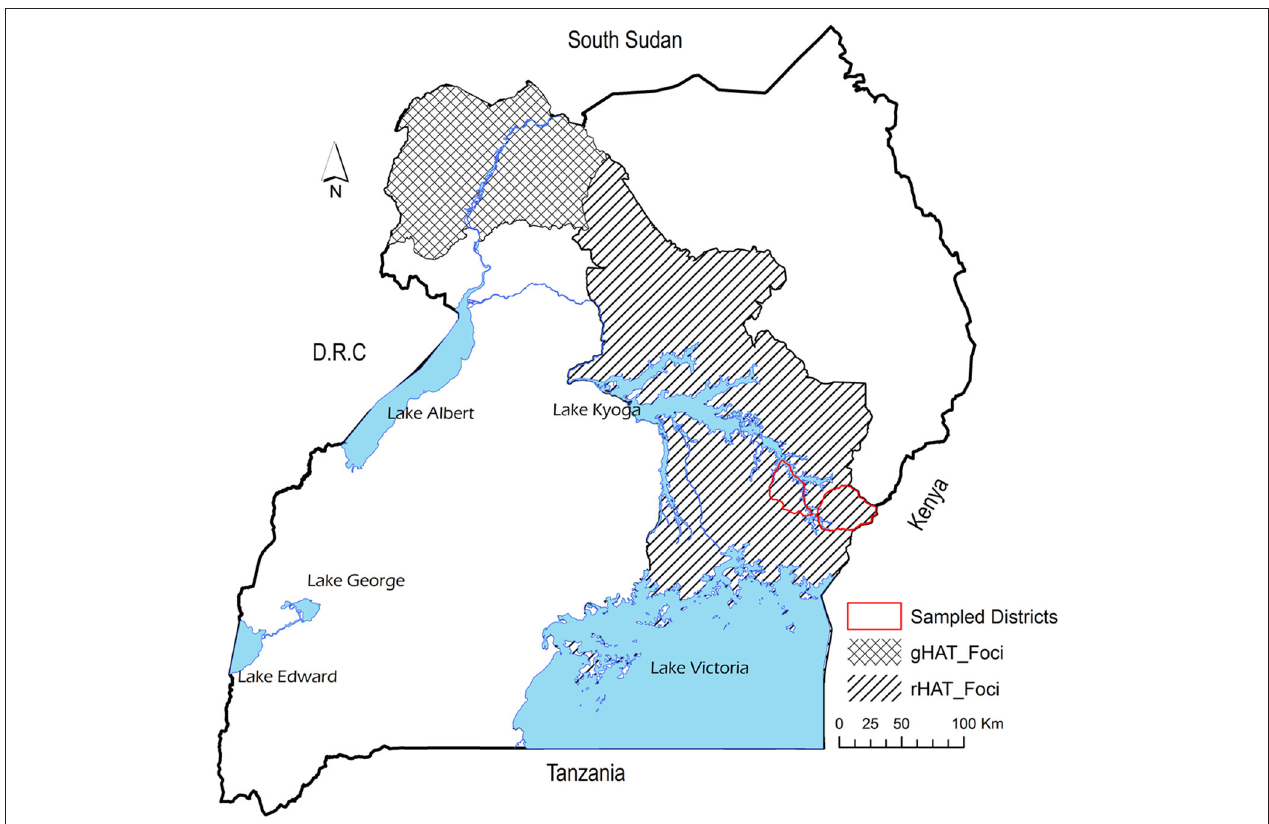
FIGURE 1 | Map showing the study area and the rHAT and gHAT